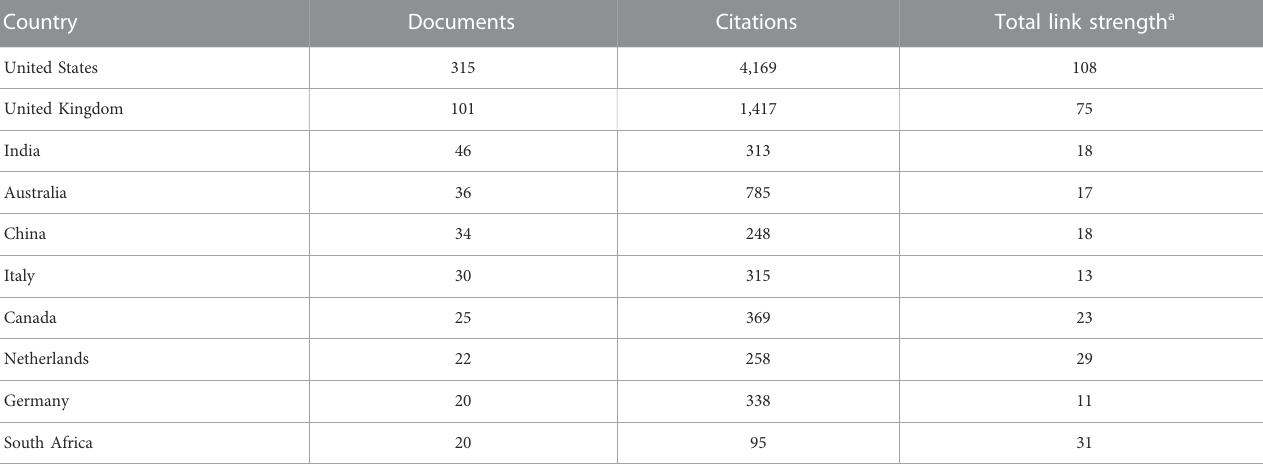
TABLE 2 The top leading countries in publishing and scienti fi c activity in the fi eld of digital pills for the period January 2012 to July 2022.